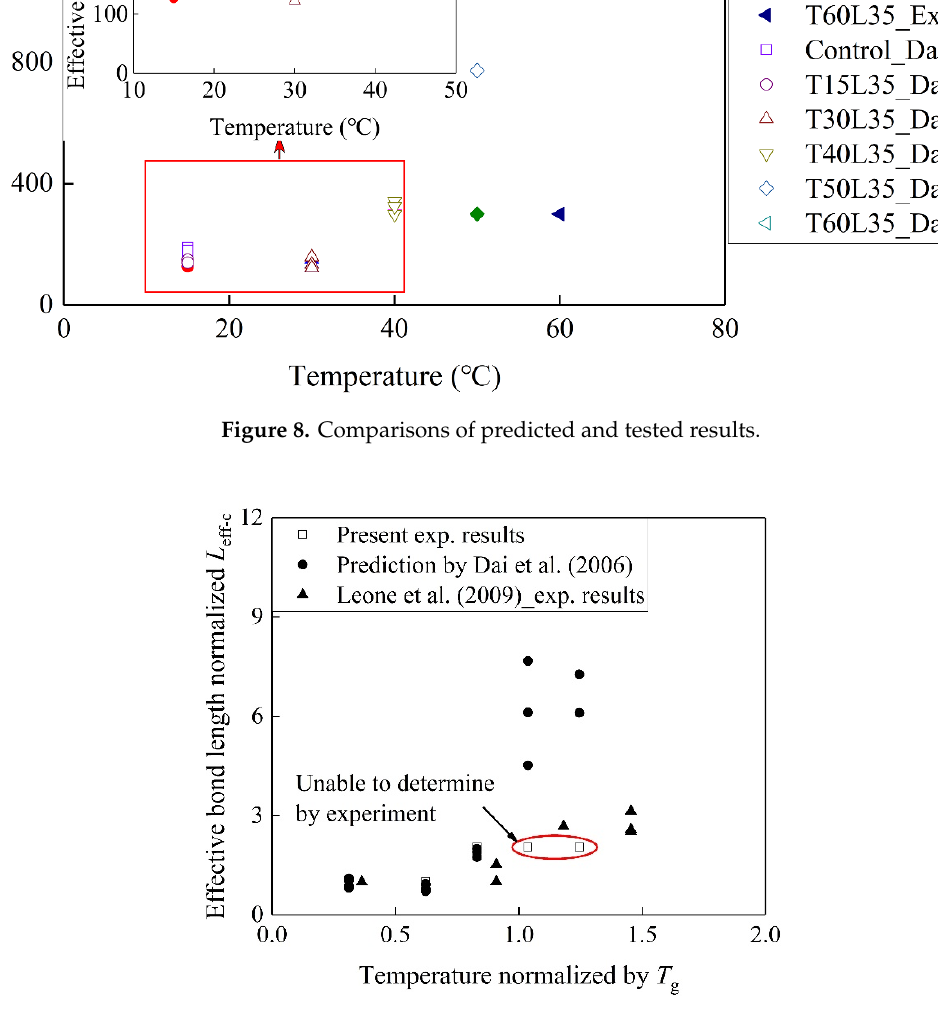
Figure 8. Comparisons of predicted and tested results.